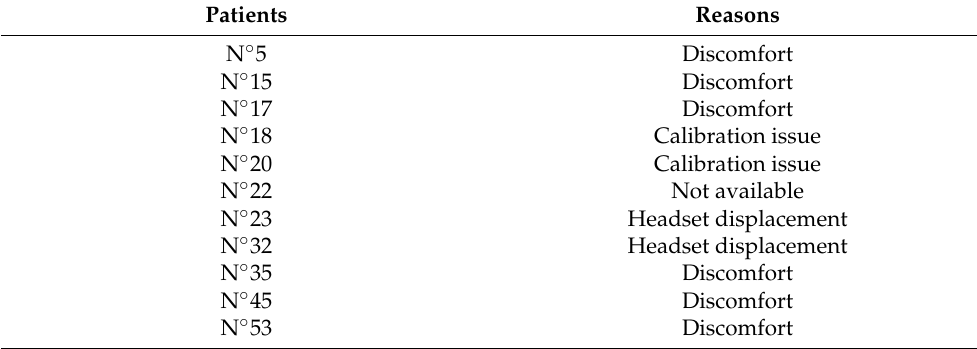
Table 2. Headset removal